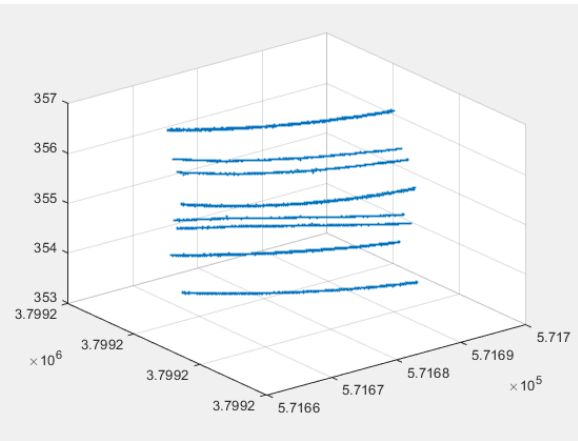
Figure 8. Result of lines